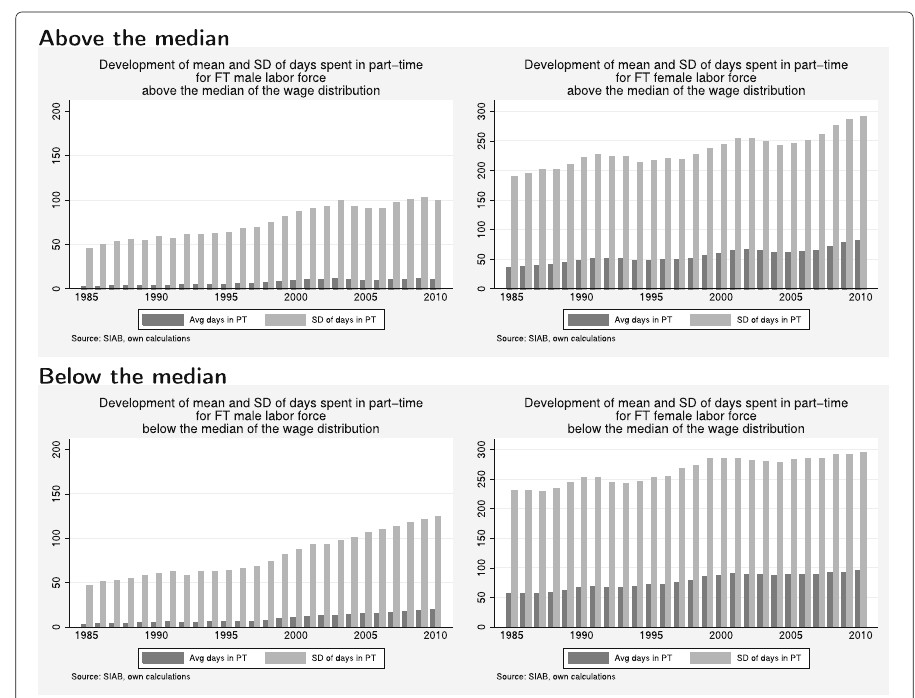
Fig. 4 Days spent in part-time work during the last 5 years (full-timers aged 25–60 years)